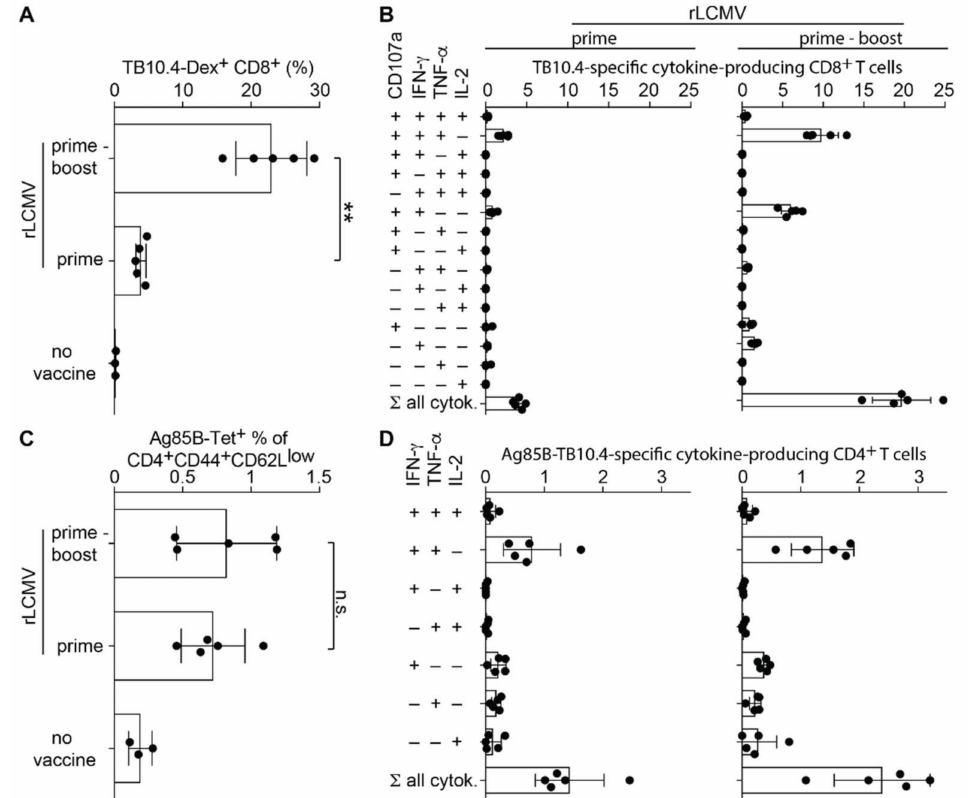
Figure 2. rLCMV-induced CD8 T cell responses are augmented by homologous boosting. We immunized C57BL/6 mice with 10 6 PFU of rLCMV i.m. on day 0 and day 28 (prime-boost) or on day 28 only (prime). Controls were left unimmunized (no vaccine, panels ( A , C ) only). On day 56, we measured T cell responses to Ag85B-TB10.4 in the spleen. ( A ): TB10.4-dextramer-binding CD8 T cells. ( B ): TB10.4-specific cytokine-producing CD8 T cells. ( C ): Ag85B-tetramer-binding cells amongst activated (CD44 + CD62L low ) CD4 T cells. ( D ): Ag85B-TB10.4-specific cytokine-producing CD4 T cells. Bars represent the mean +/ − SD of five mice per group. Black circles show individual mice. Values in ( B , D ) are background-subtracted (cytokine secretion upon peptide/antigen stimulation minus cytokine secretion in medium-only control wells). One representative experiment of two similar ones is shown. Responses of mice immunized with either one or two doses of rLCMV were compared by unpaired two-tailed Student’s t -test. ** p < 0.01; n.s.: not statistically significant, p ≥